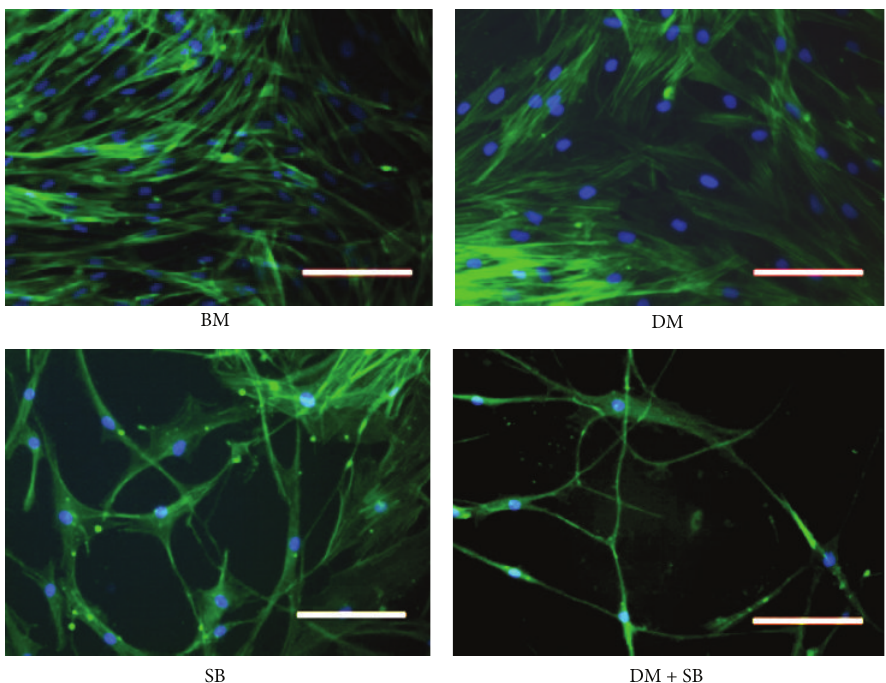
Figure 1: Human adipose derived stem cells (hADSCs) express neurite outgrowths upon dual inhibition of activin/nodal/TGF- 𝛽 and BMP signaling pathways. hADSCs were cultured in basal medium DMEM containing 10% FBS (BM) or BM containing either activin/nodal/TGF- 𝛽 pathway inhibitor SB431542 (SB) or BMP pathway inhibitor dorsomorphin (DM) or both for 14 days. Cells were stained with DAPI (staining nuclei) as well as FITC conjugated phalloidin (staining F-actin) and images were captured under a fluorescent microscope. Addition of SB or SB + DM induced neurite outgrowths in hADSCs. The length of neurite outgrowth in SB + DM group was significantly longer in comparison with other groups. Scale bar = 100 𝜇 m.